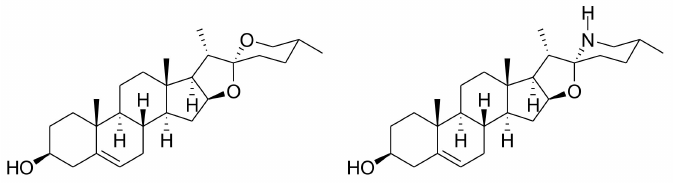
Figure 1. Diosgenin and solasodine